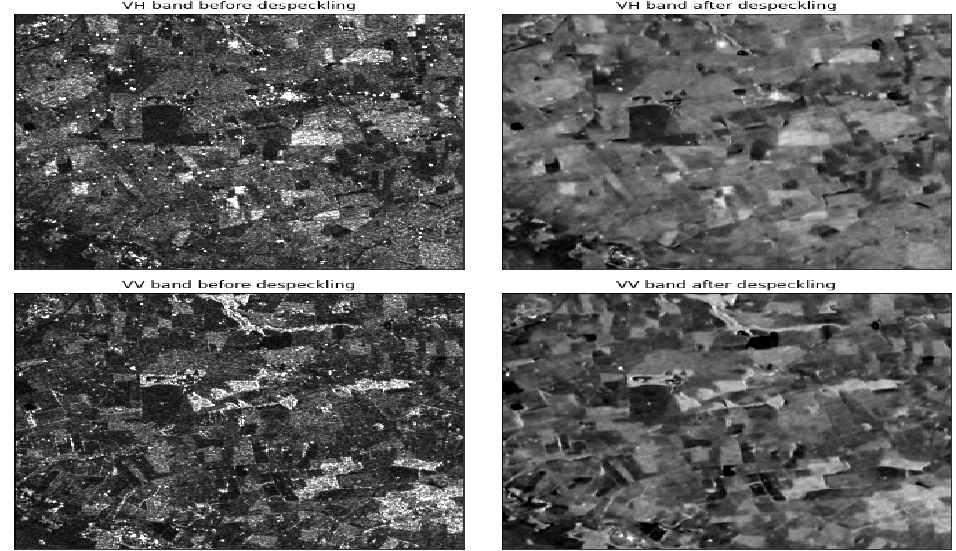
Figure 5. Images for VV and VH polarizations before and after applying the transformation and despeckling. The process may have caused some loss of sharpness, but it is generally a significant improvement compared to more traditional speckle filtering techniques